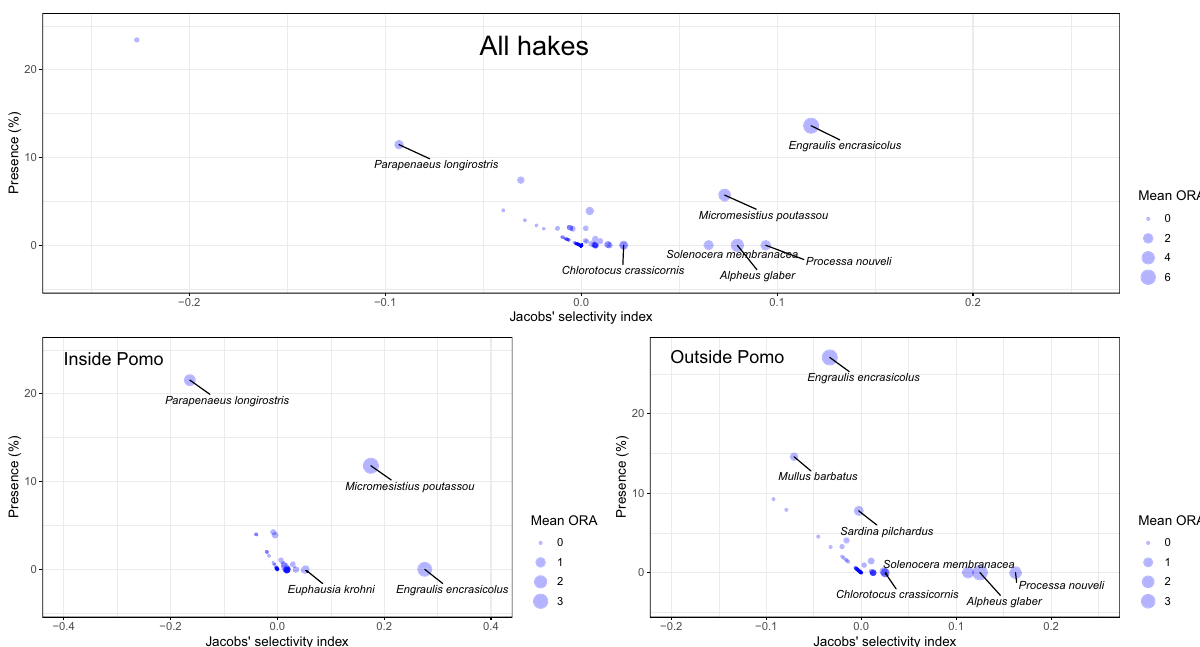
Figure 5. Phylum trophic significance based on presence (%), on individuals/km 2 , on mean ORA (%) in stomach samples and Jacobs’ selectivity index. Species with a mean ORA > 1 are shown. Analysis performed by using the R package selectapref 80 in R environment 77